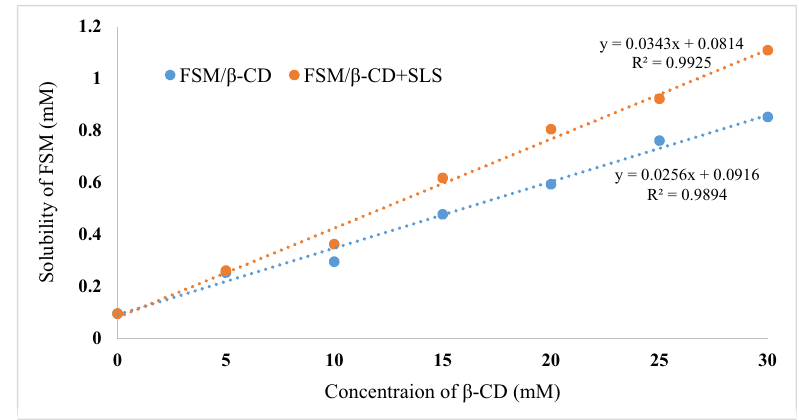
Figure 2: Phase solubility curves of FSM/ β - CD and FSM/ β - CD with